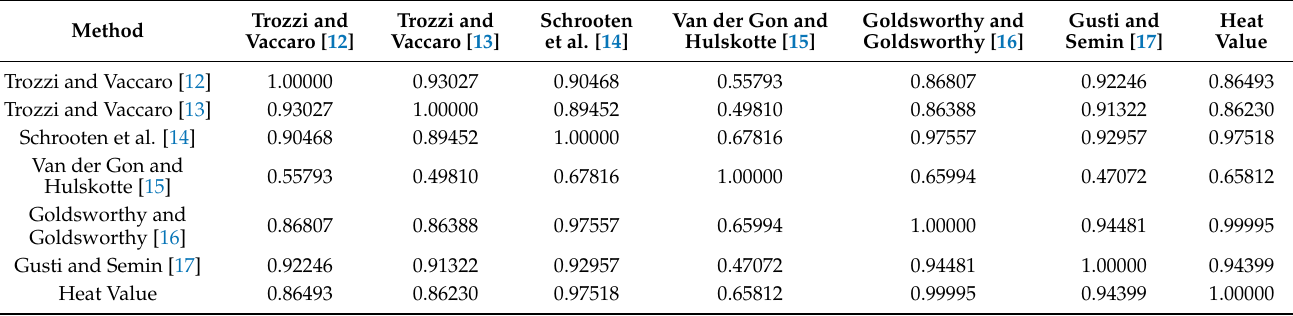
Table 9. Correlation Coefficient (R 2 ) according to Pearson test.